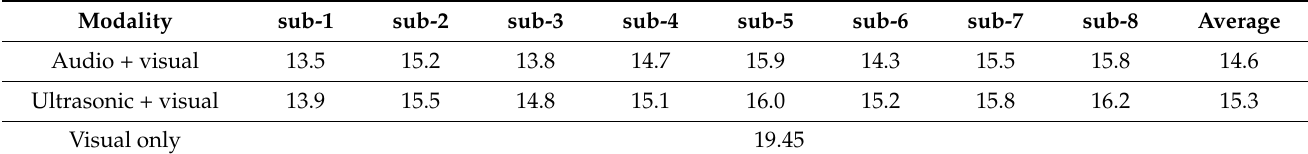
Table 4. The MAPEs for each modality and each subject (sub-1 ∼